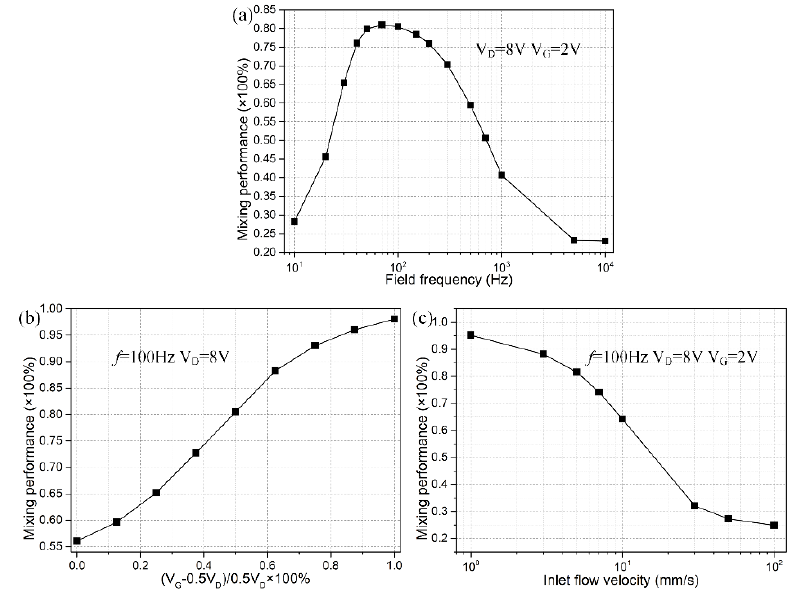
Figure 6. A parametric study of the 3D ICEO micromixer with ac field-effect control of lateral ICEO convection. ( a ) Frequency-dependence of mixing performance, for V D = 8 V and V G = 2 V; ( b ) Effect of gate potential offset on the device mixing behavior at frequency f = 100 Hz and driving voltage V D = 8 V; ( c ) Effect of inlet flow rate on the mixing efficiency under given frequency f = 100 Hz, driving voltage V D = 8 V, and gate voltage V G = 1.5 V, being equivalent to an offset ratio of 0.625.